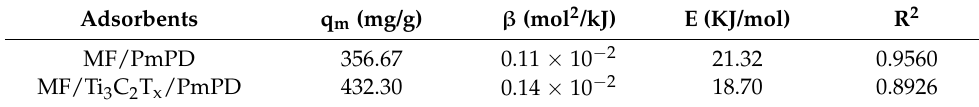
When the initial concentration of Cr(VI) was 100 mg/L, the influence of time on the adsorption performance of MF/PmPD and MF/Ti 3 C 2 T x /PmPD for Cr(VI) was